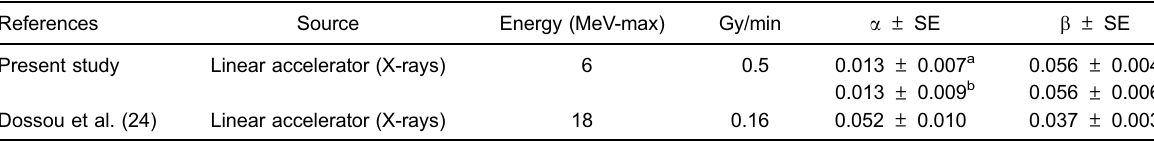
Table 5. Comparison of fi tted linear and quadratic yield coef fi cients for dicentric aberrations induced by LINAC